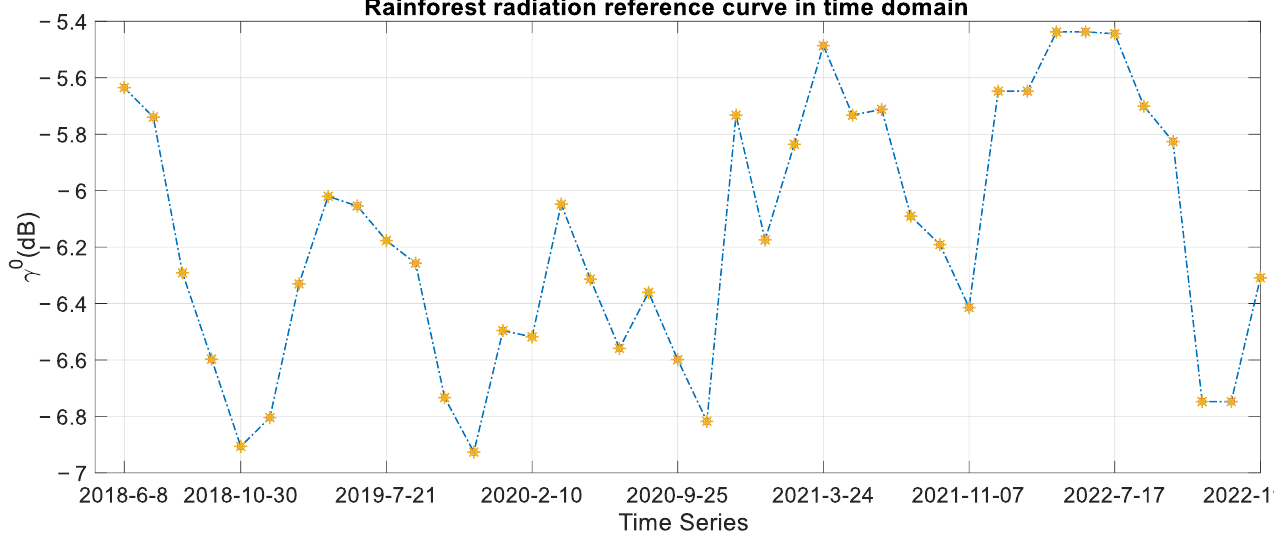
Figure 10. The curve of mean radiation intensity for experimental rainforest data.